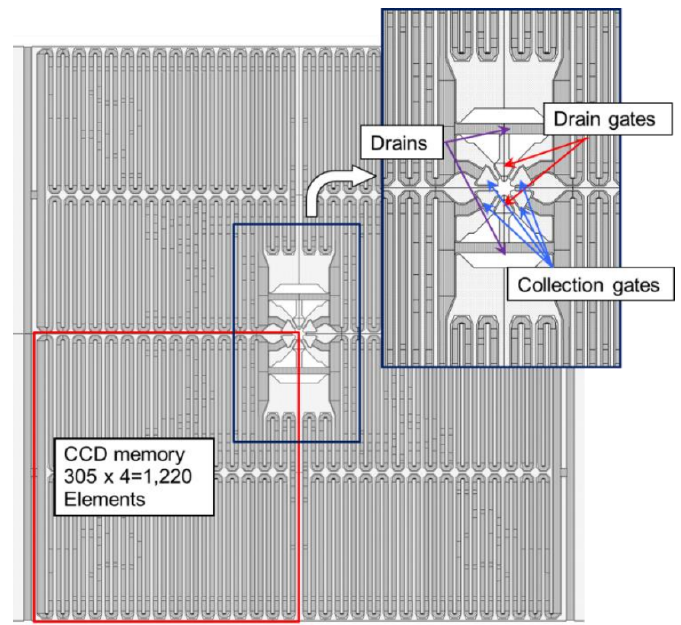
Figure 2. A pixel of the BSI MCG ISAS with four collection gates and four in-pixel folded looped CCD memories (the frame count is 1220